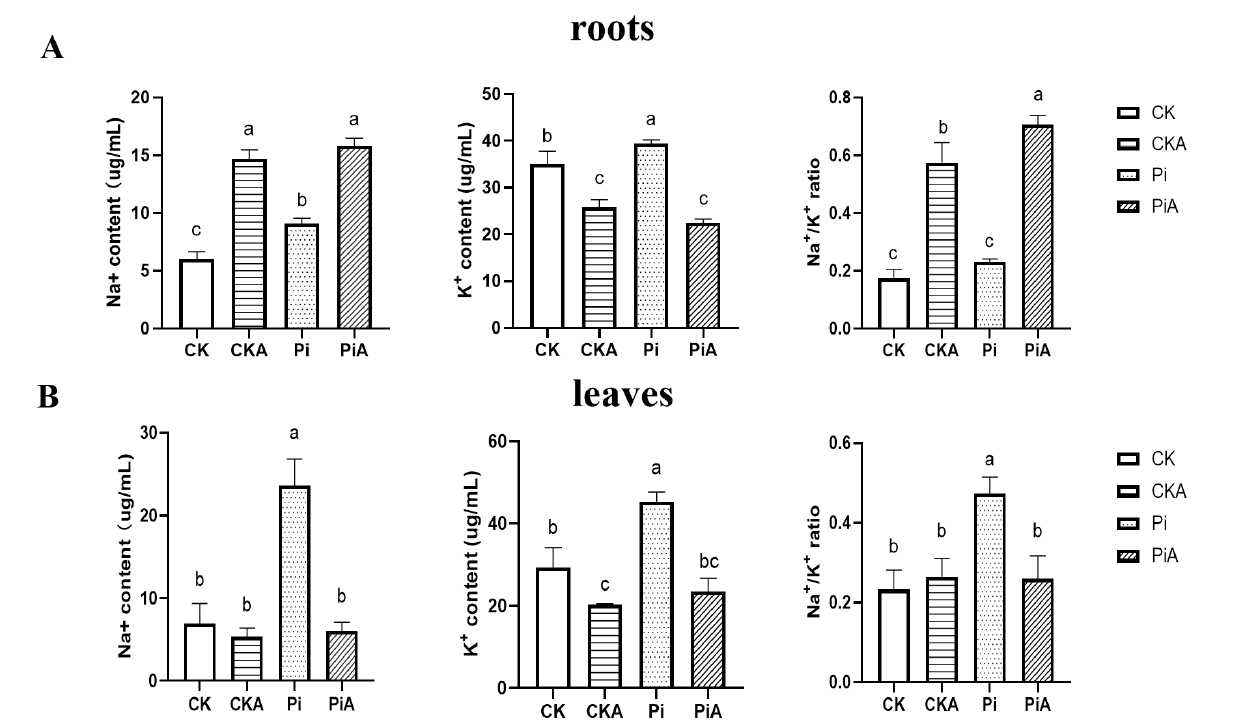
Figure 6. Changes in Na + and K + contents and Na + /K + ratio in soybean roots ( A ) and leaves ( B ) of P. indica colonization (Pi) and non-colonized plants (CK) after salt treatment for nine days. The values are the means ± SDs of three replicates. Different letters above the bars indicate a significant difference ( p < 0.05).